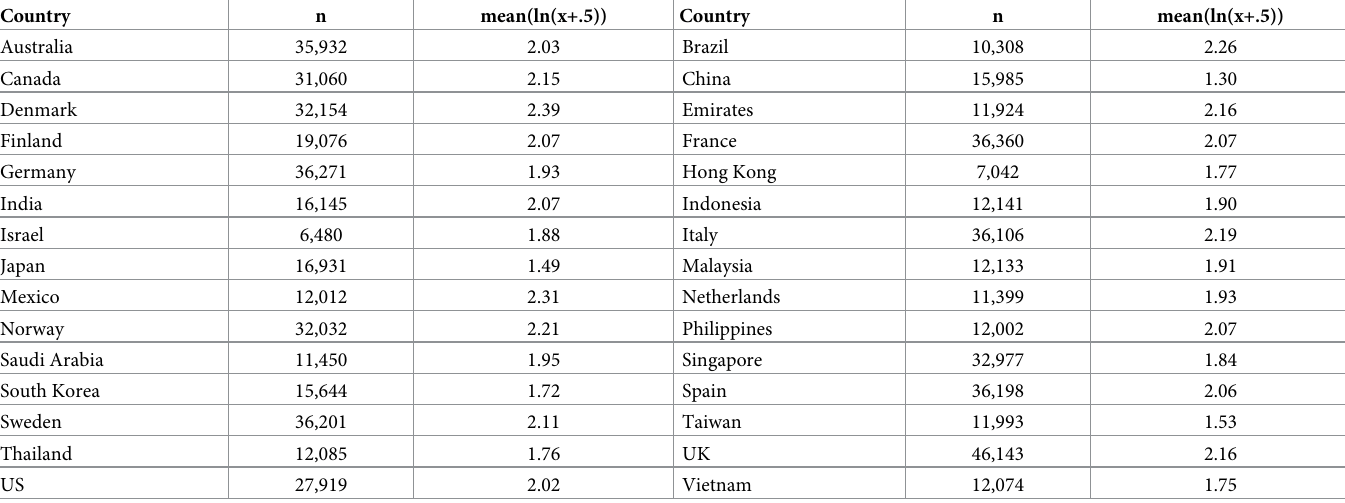
Table 1. Countries in the imperial database, number of respondents with complete data for the questions analyzed here, and the mean for the natural logarithm of the responses to the free recall question, plus a starting value of +.5, for the 25% of the training sample (given the sample sizes these are very similar to the total